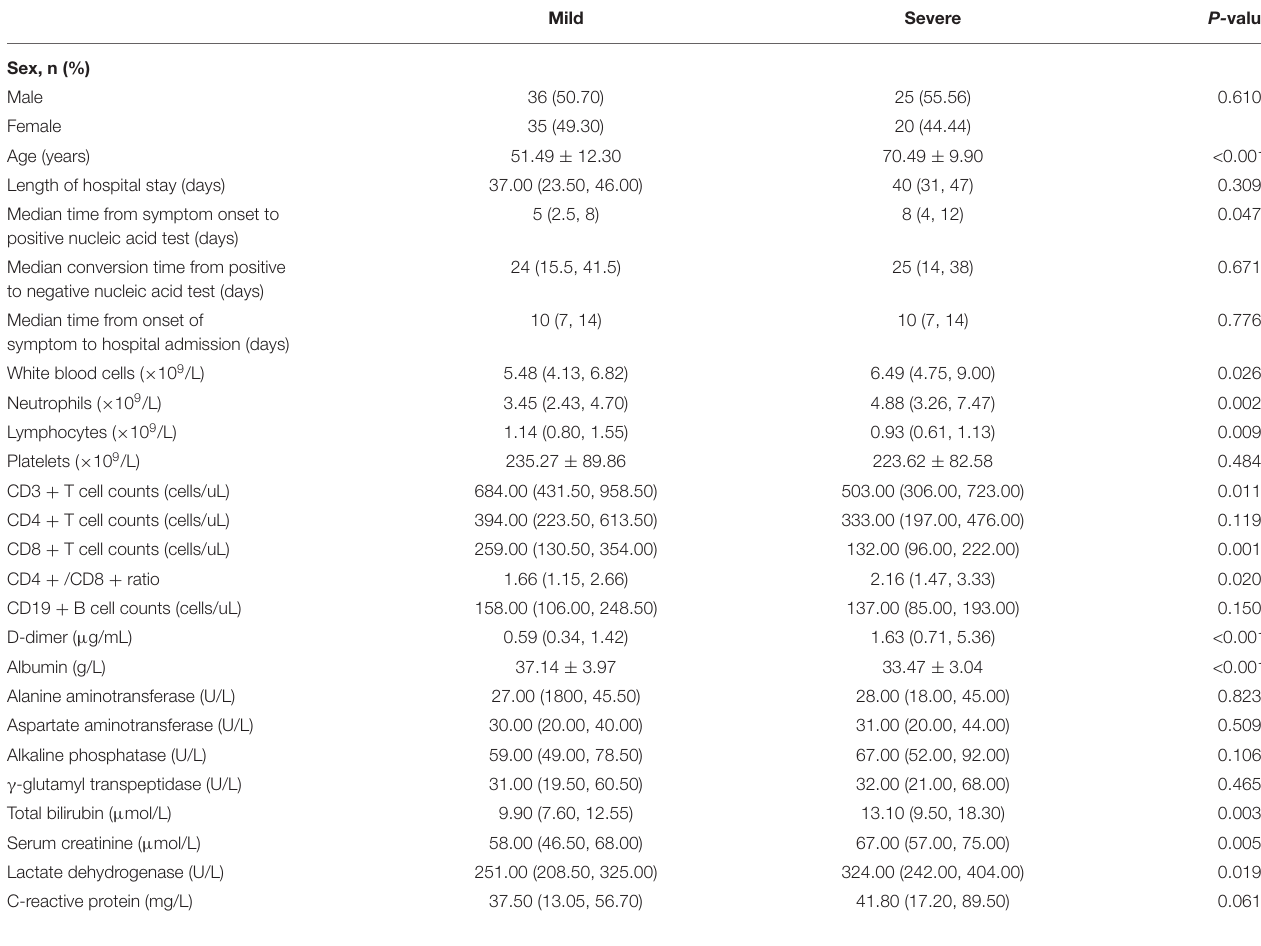
TABLE 5 | Comparison of clinical characteristics and laboratory findings between mild and severe patients with COVID-19. Mild Severe P-